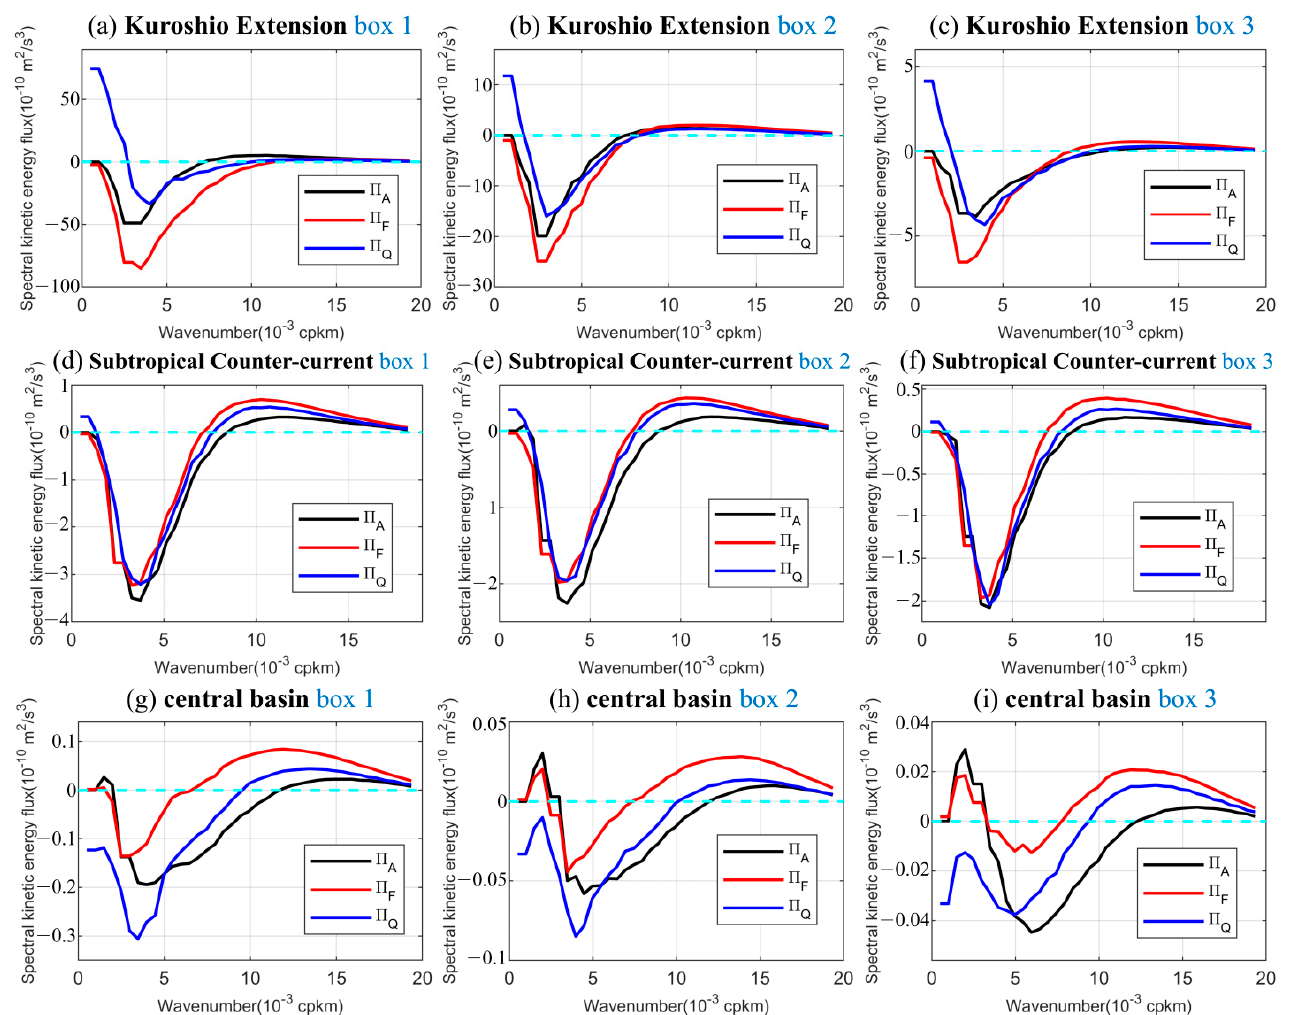
Figure 7. Same as Figure 5 except based on the preprocessed velocity data.